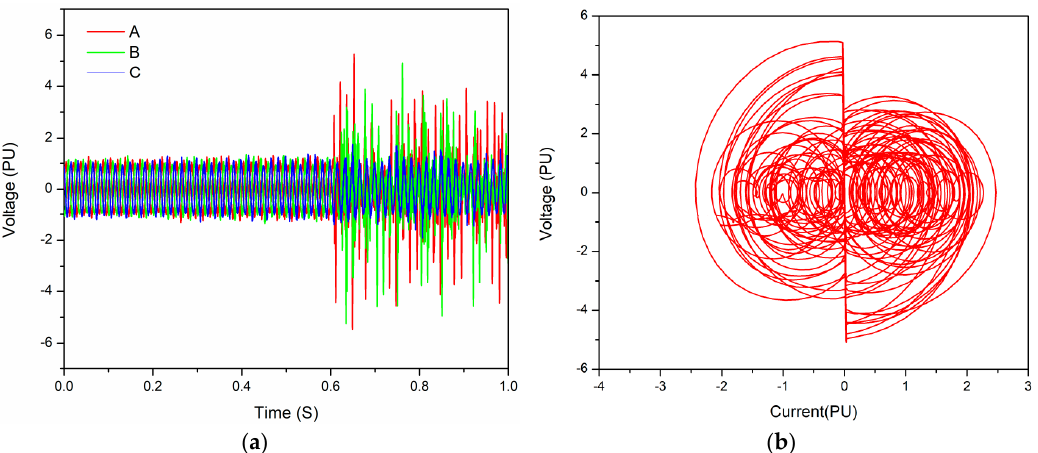
Figure 9. The ferroresonant results during de ‐ energization at 0.6 secs on the SCIG wind turbine: ( a ) Voltage waveform of phase A, B and C with highest overvoltage on phase A; ( b ) Phase plane diagram of phase B having chaos.